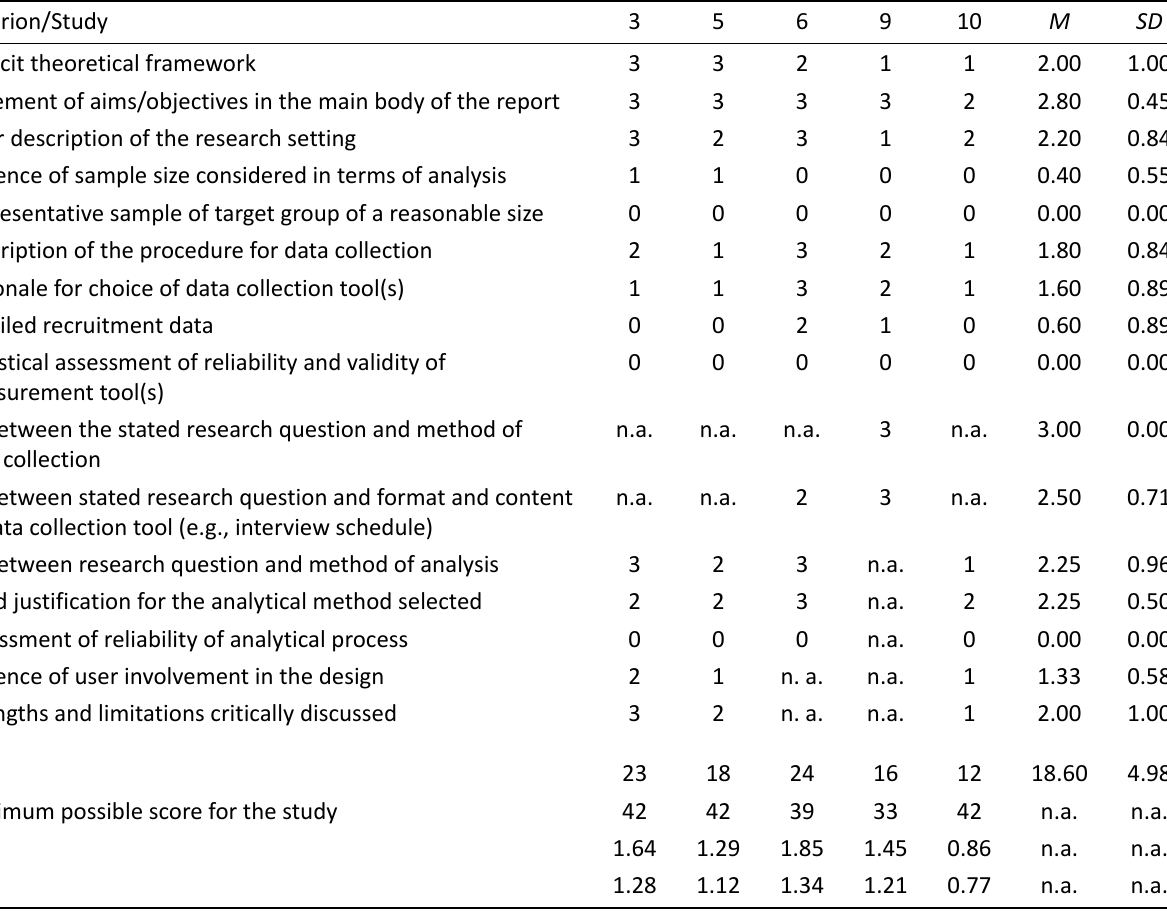
Table 3. Implementation of the 16‐item QATSDD (Sirriyeh et al., 2012) to the sample of empirical studies ( N = 5).